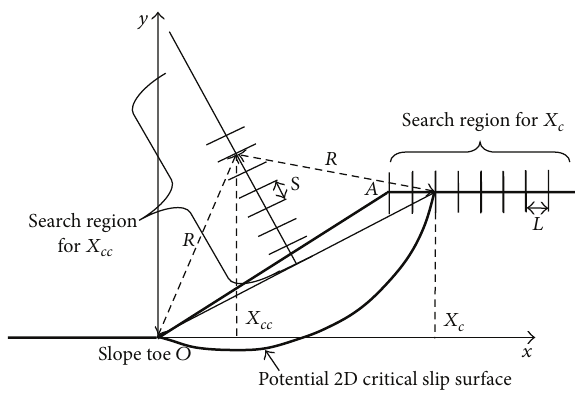
Table 2: Selected individuals.